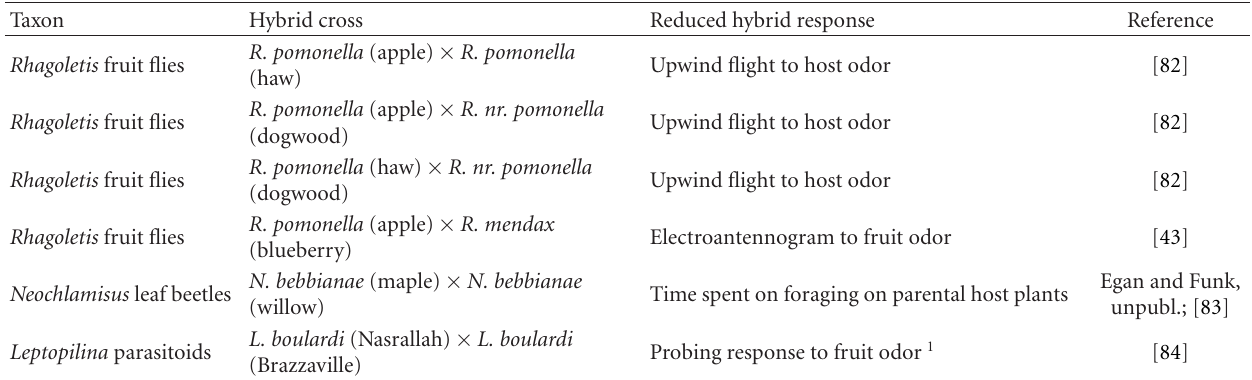
Table 4: Studies presenting data consistent with habitat avoidance alleles causing problems in hybrids. Each cross-generated hybrids displaying reduced response relative to parents in habitat choice. Host plant or locality information is in